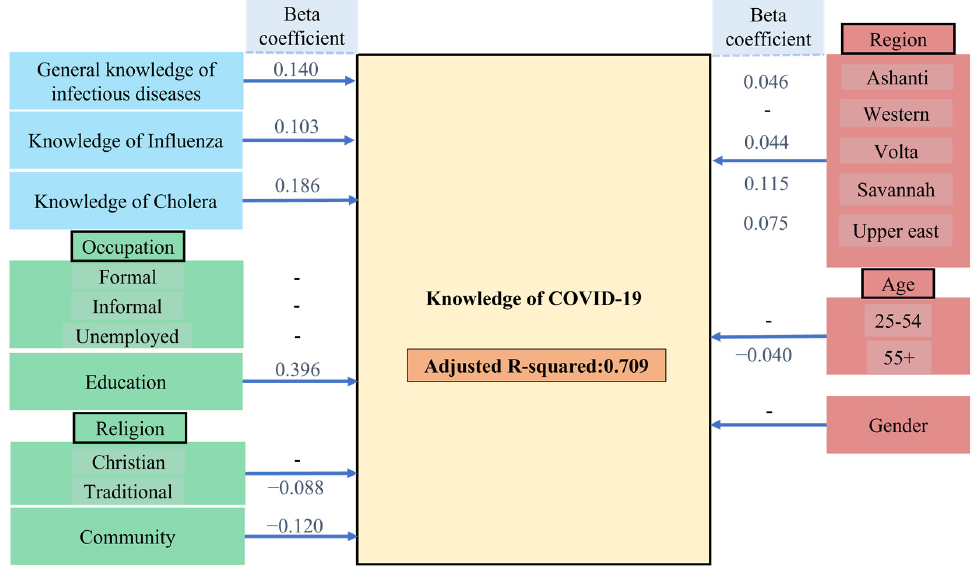
Figure 4. The extended knowledge of COVID-19 model (E-KCM) employed to assess the influences of the socio-demographic characteristics on the knowledge of COVID-19. The results are shown in terms of regression coefficient estimates and beta coefficients. The level of explained variance in the results of this model was 70.9%.